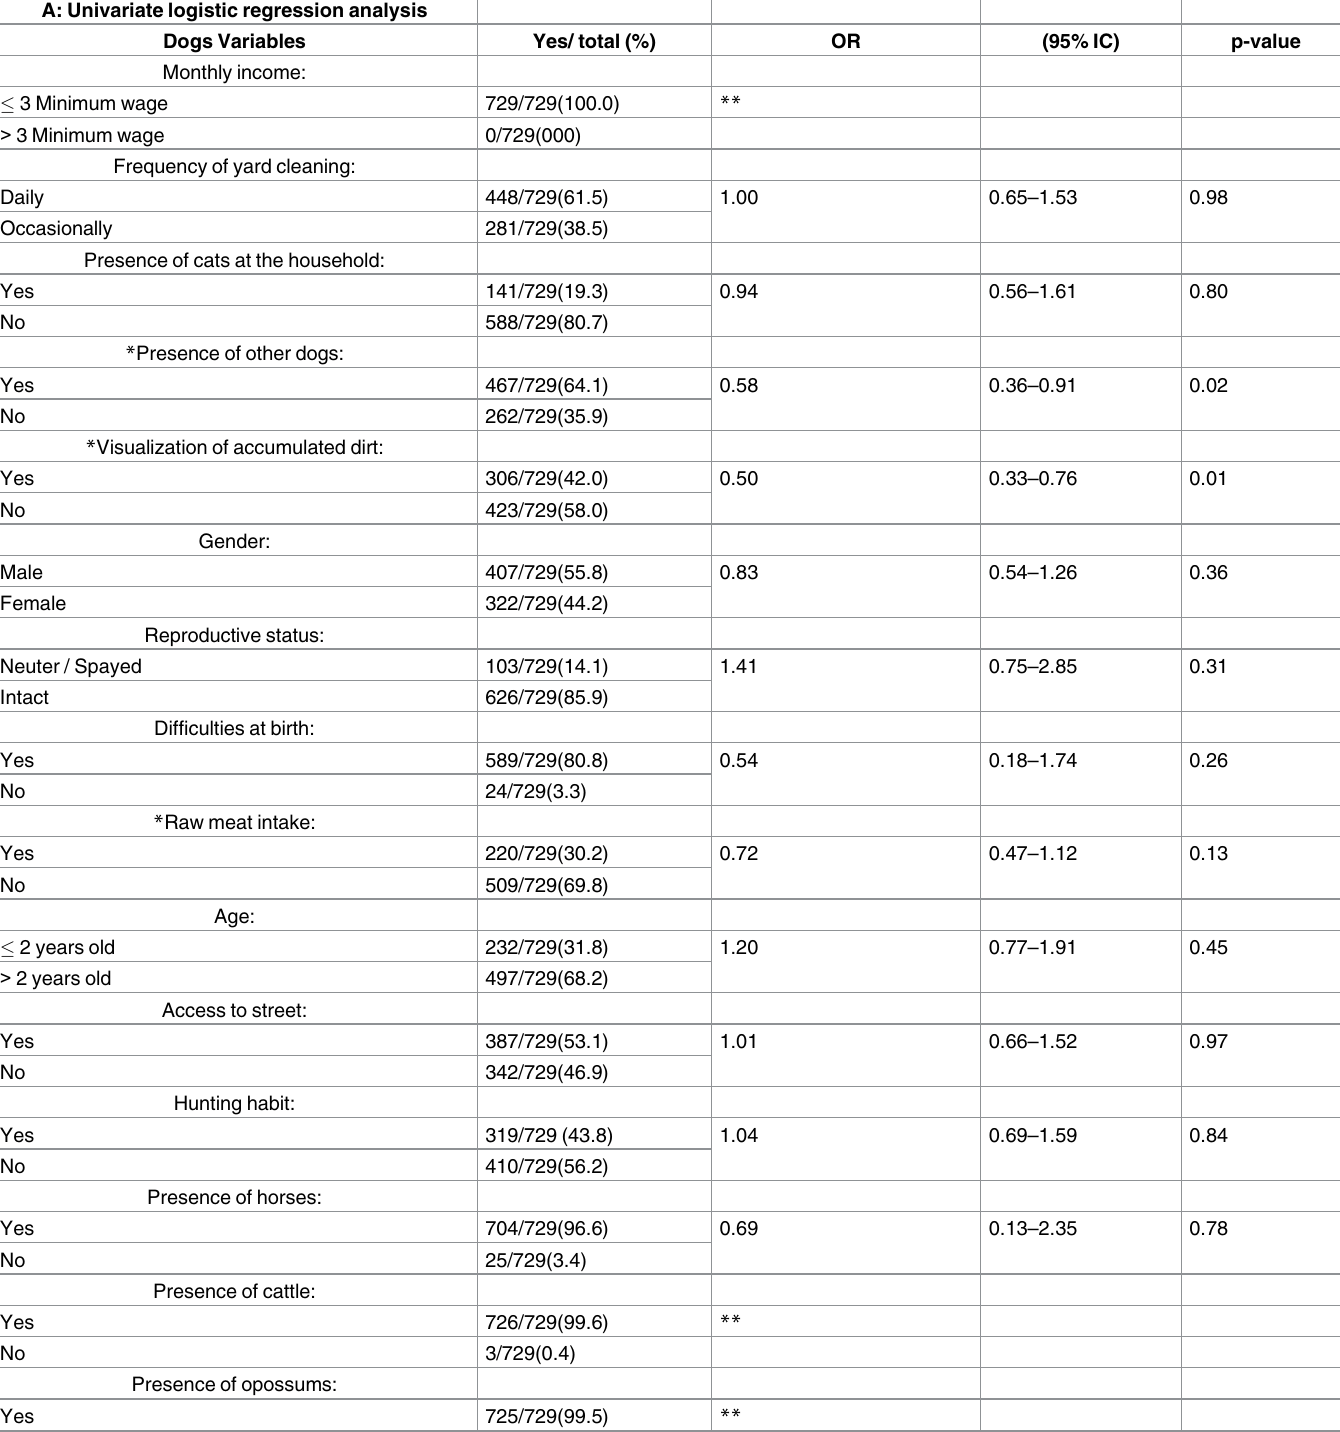
Table 3. Results of univariate logistic regression analysis of 729 dogs with IgG anti- T . gondii antibodies detected by IFAT in the urban area of Lon- drina from July 2015 to July 2016. A: Univariate logistic regression